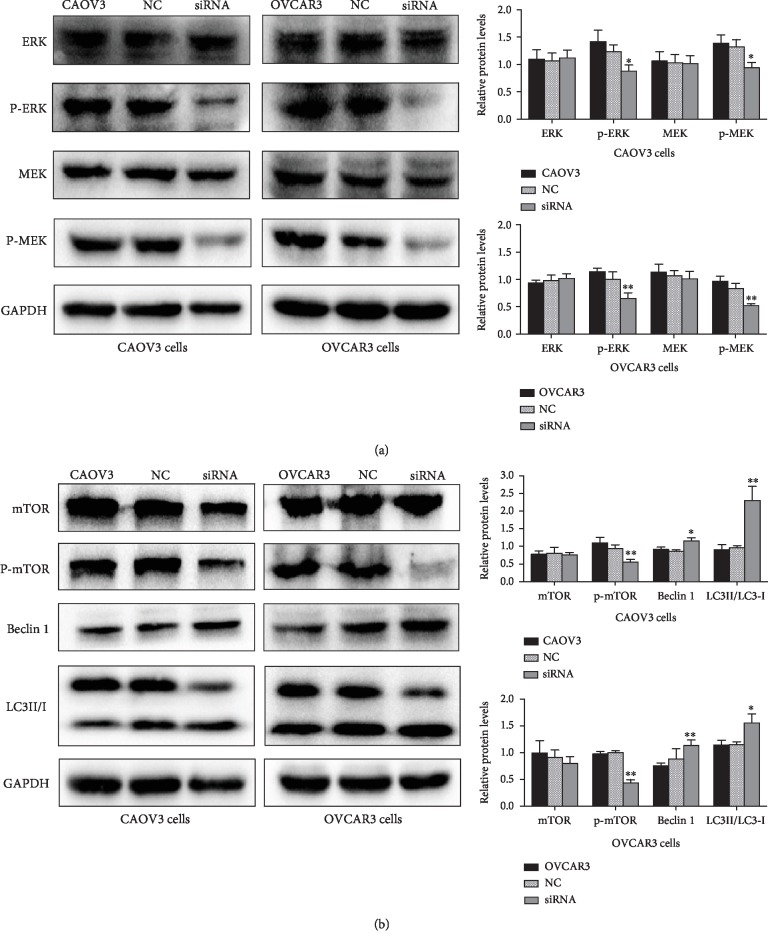
Effect of BMPER siRNA transfection on MAPK and autophagy-related signaling pathways in CAOV3 and OVCAR3 cells. The levels of the MAPK signaling pathway molecules ERK, p-ERK, MEK, and p-MEK and the autophagy-related pathway molecules mTOR, p-mTOR, Beclin 1, and LC3 were detected by Western blot after transfection. GAPDH was used as the internal standard. Inhibition of BMPER reduced the phosphorylation of MAPK signaling pathway-associated proteins (p-ERK, p-MEK) (a), but promoted the expression of autophagy-related signaling pathway molecules (b). ∗P < 0.05, ∗∗P < 0.01.